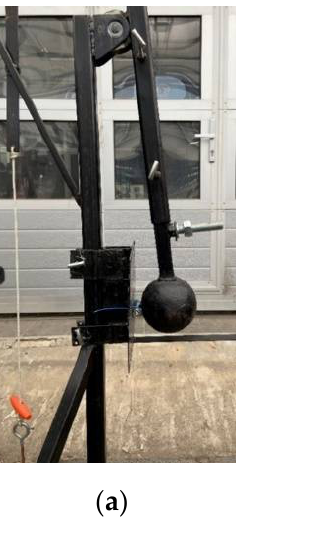
Figure 8. Battery impact test: ( a ) impact pendulum; ( b ) impact ball and battery before and after impact.